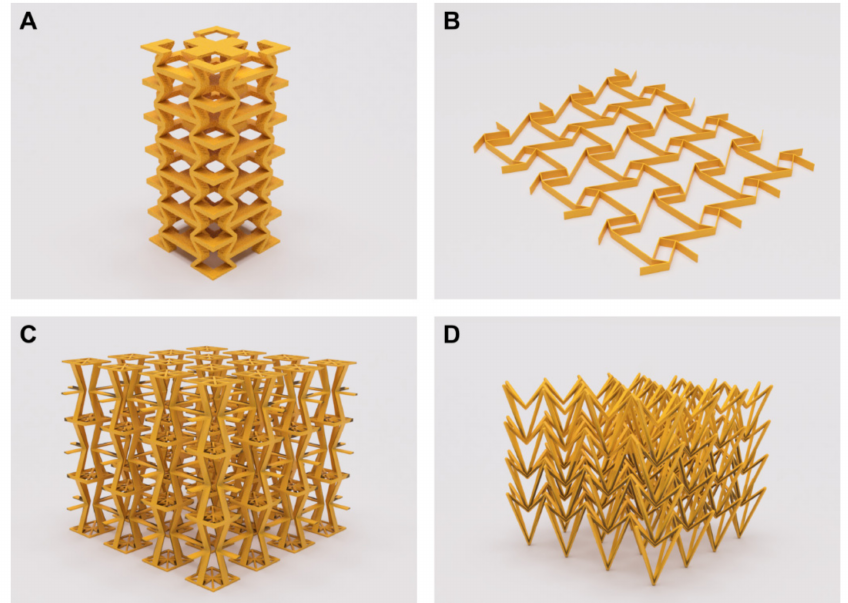
Figure 1. Examples of auxetics that can be used in different medical applications. ( A , C ) three- dimensional auxetics based on a re-entrant cell. ( B ) Two-dimensional lattice structure based on a re-entrant cell. ( D ) Three-dimensional auxetic based on an arrow-head unit